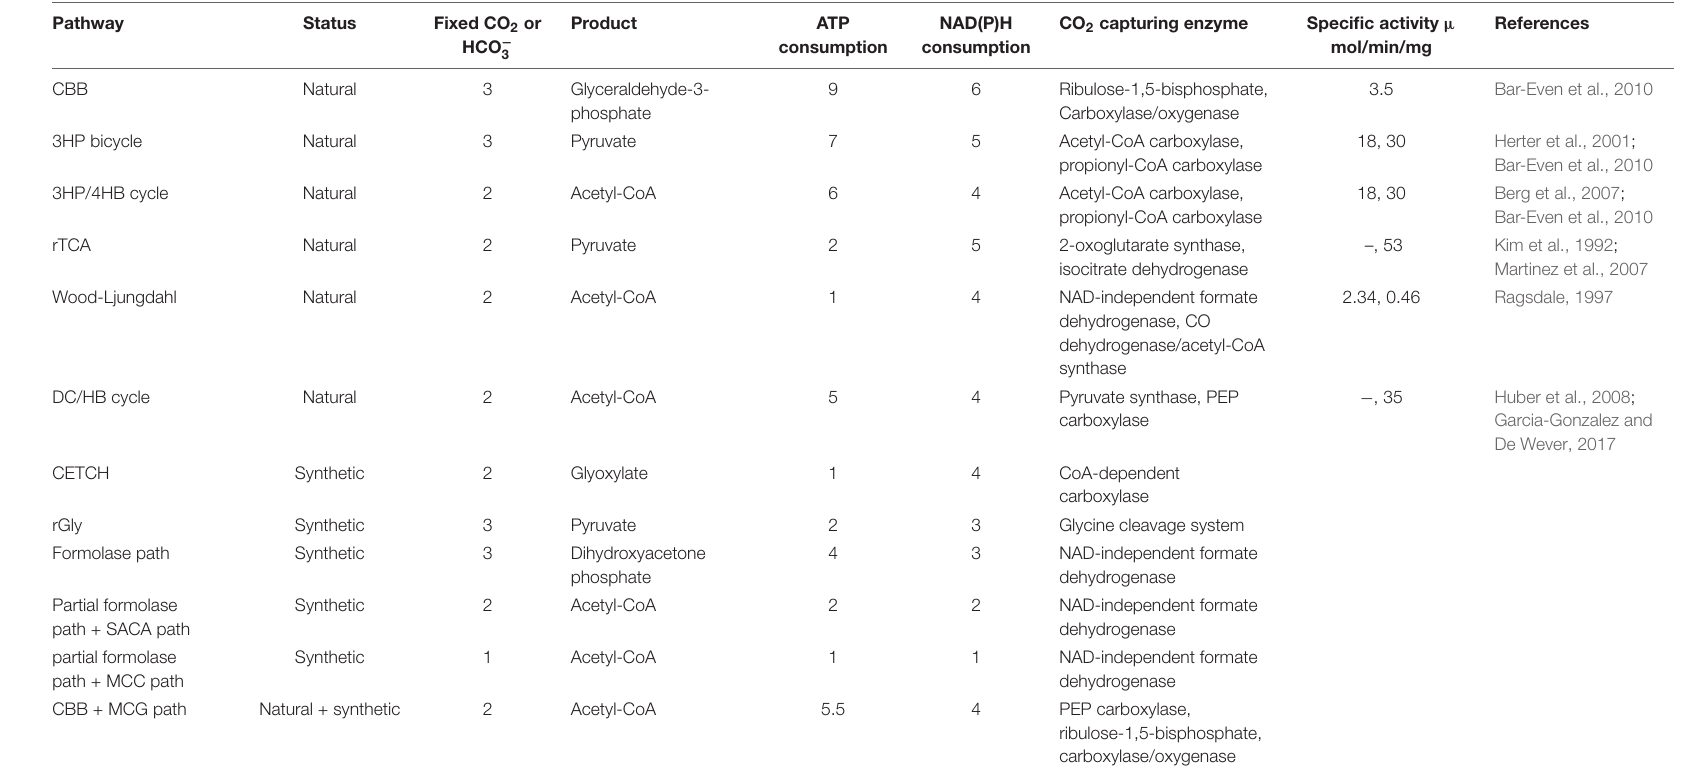
TABLE 1 | Comparison of synthetic CO 2 fixation pathways with natural ones.